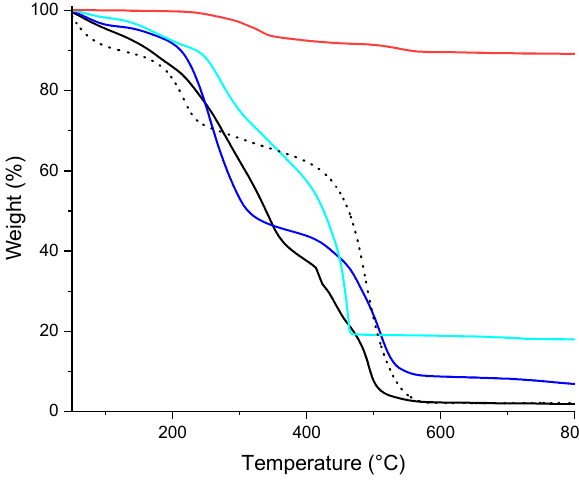
Figure 2. Thermogravimetric analysis (TGA) thermograms of Graphene Oxide (GO) (dotted line), PVA@GO (black line), PVA@rGO-Ag1 (blue line), PVA@rGO-Ag2 (cyan line), and PVA@rGO-Ag3 (red line), air atmosphere.